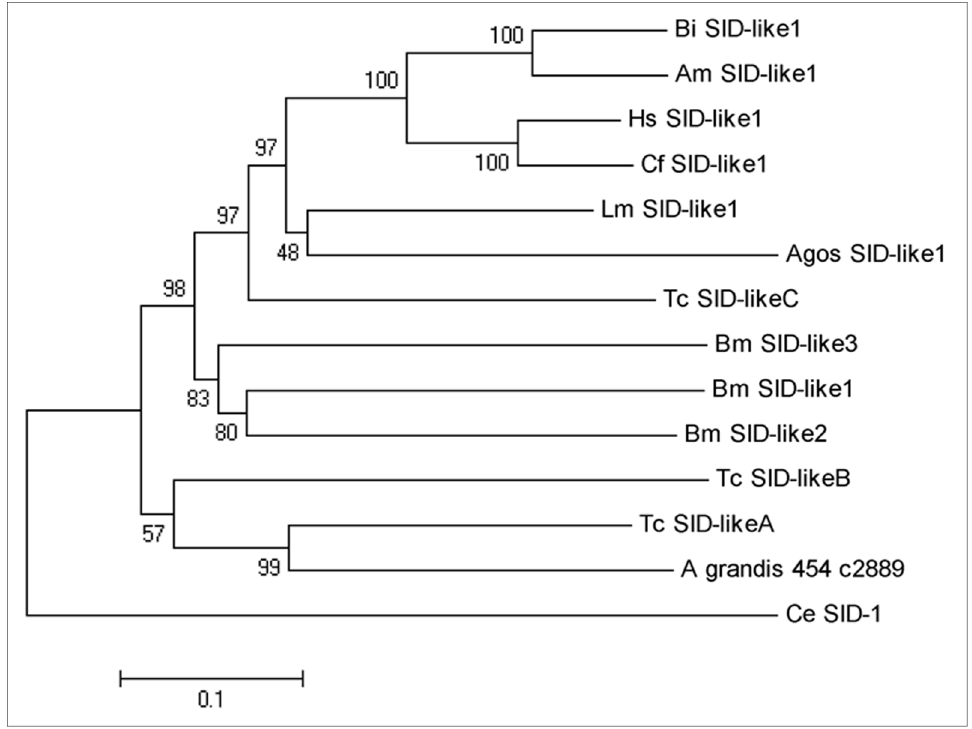
Figure 6. Distance neighbor-joining tree showing the phylogeny of a SID-like contig of A. grandis (A_grandis_454_c2889) and SID-like proteins of the insects T. castaneum , B. impatiens , A. mellifera , L. migratoria , B. mori , A. gossypii , H. saltator , Camponotus floridanus . The percentage of percentage of bootstrap confidence values is shown at the nodes. doi: